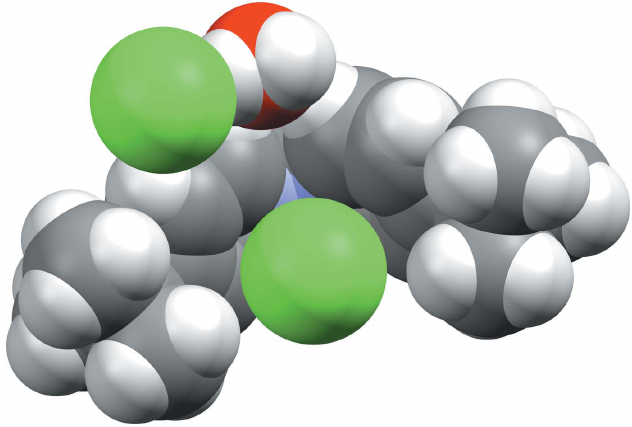
Figure 2 Space-filling representation of the title compound showing one chloride hydrogen bonded to the water molecule and a chloride ion clamped between the aromatic